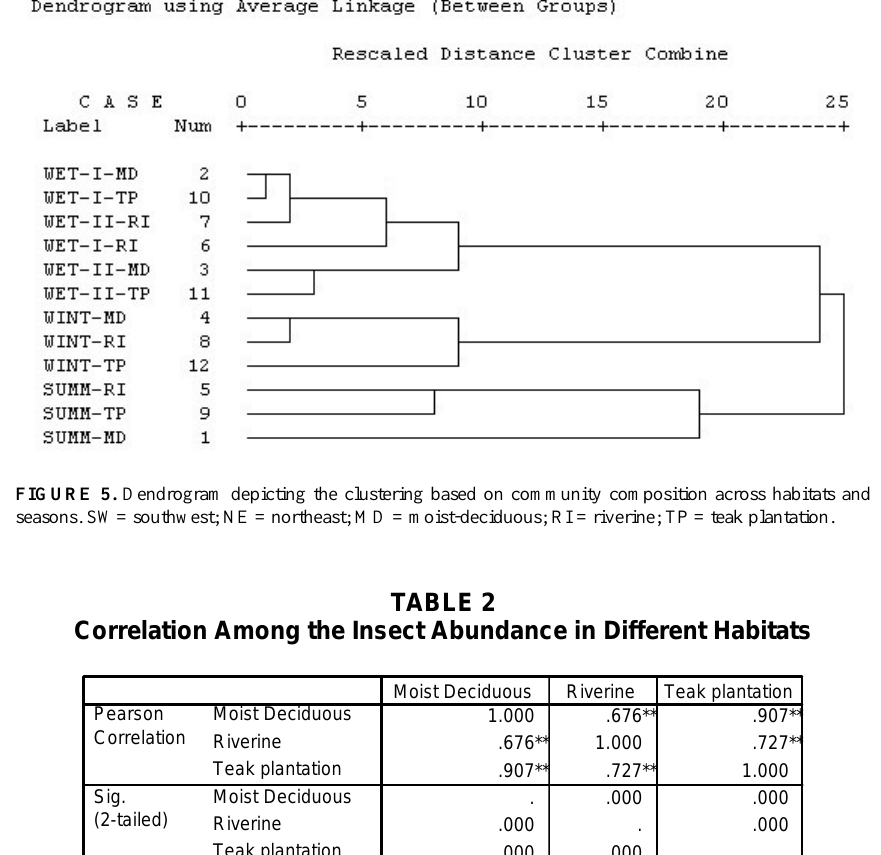
1.000 .676** .907** .676** 1.000 .727** .907** .727** 1.000 . .000 .000 .000 . .000 .000 .000 . 24 24 24 24 24